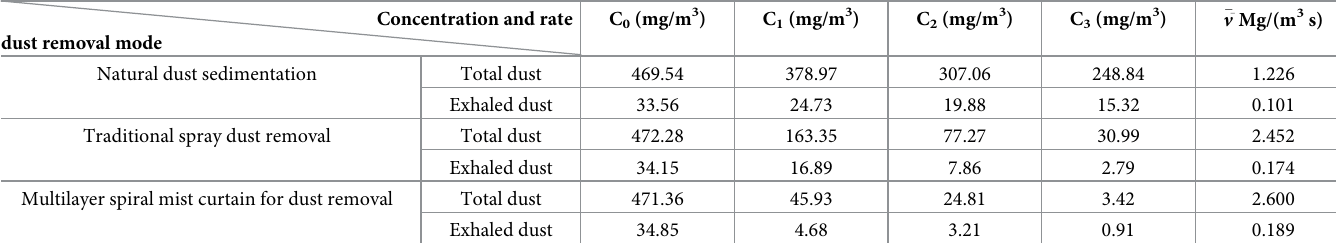
Table 2. Comparison of the dust concentration changes and dust removal rates at different times under three dust removal